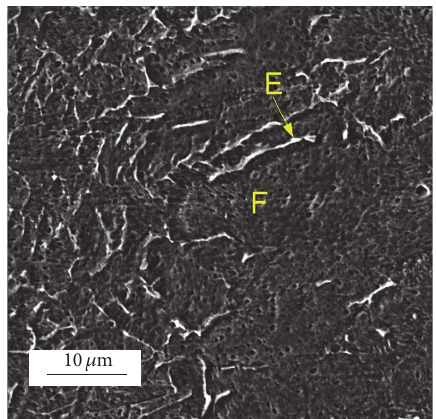
Figure 18: The selected region to detect Cr carbide in HAZ near AISI 316L base